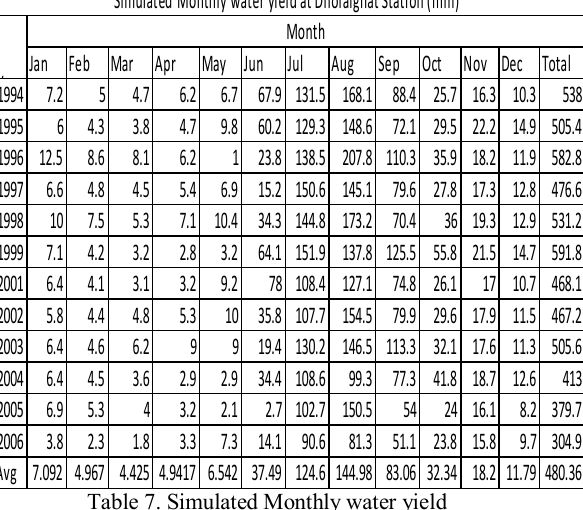
Simulated Monthly water yield at Dholalghat Station (mm)